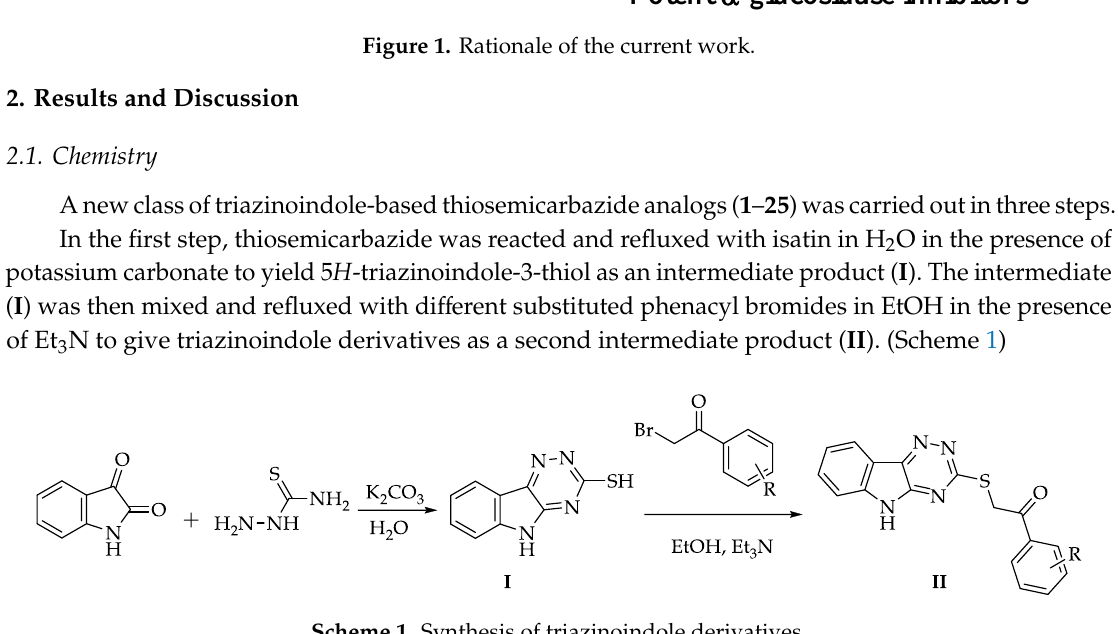
Scheme 1. Synthesis of triazinoindole derivatives.